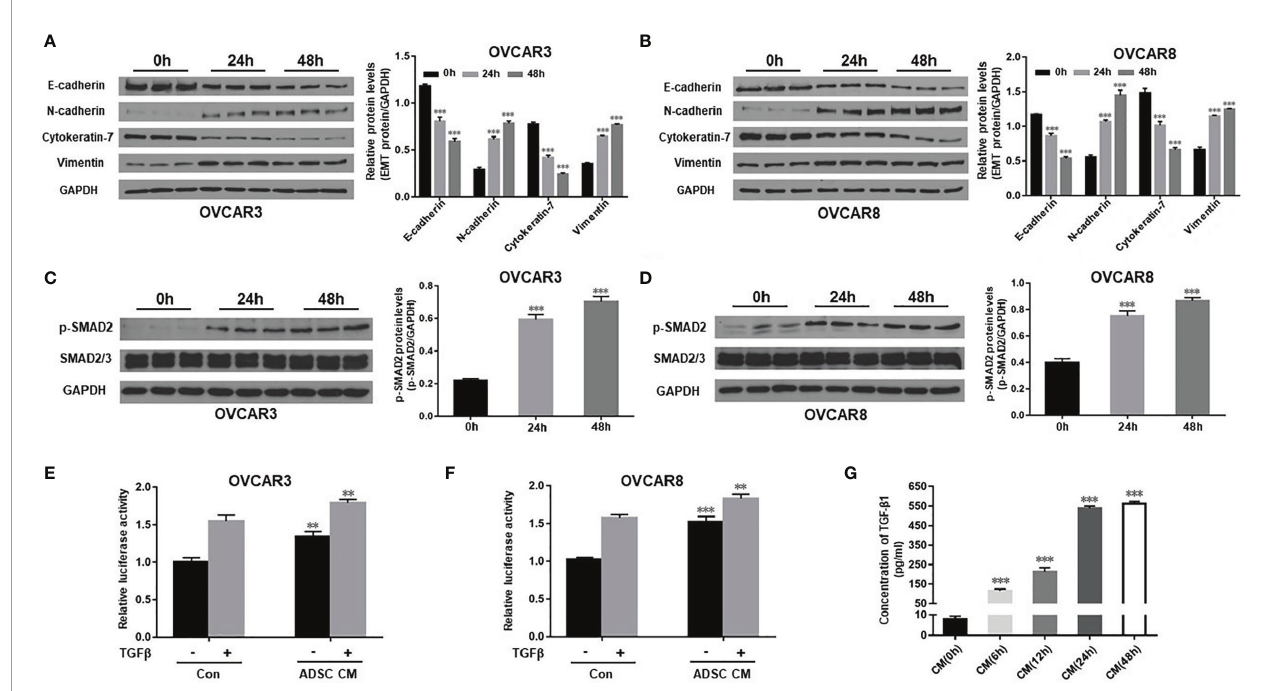
FIGURE 2 | ADSC promotes EMT by activating the TGF- b signaling pathway in OC cells. (A, B) Western blot analysis of EMT markers in both OVCAR3 (A) and OVCAR8 (B) cells following treatment with ADSC-CM for different time durations (0, 24, and 48 h). Right, the quanti fi cation analysis of the blots. (C, D) Western blot analysis of the p-SMAD2 and SMAD2/3 expression in both OVCAR3 (C) and OVCAR8 (D) cells following treatment with ADSC-CM for different time durations. Right, the quanti fi cation analysis of the blots. (E, F) Luciferase activity in OVCAR3 (E) and OVCAR8 (F) cells following ADSC-CM treatment for 24 h, then 6 ng/ml TGF- b treatment for 12 h. (G) ELISA analysis of ADSC-CM collected at different time points to detect the concentrations of TGF- b 1. Data represent the mean ± SD of three independent experiments. ** p < 0.01, *** p < 0.001 compared with the control